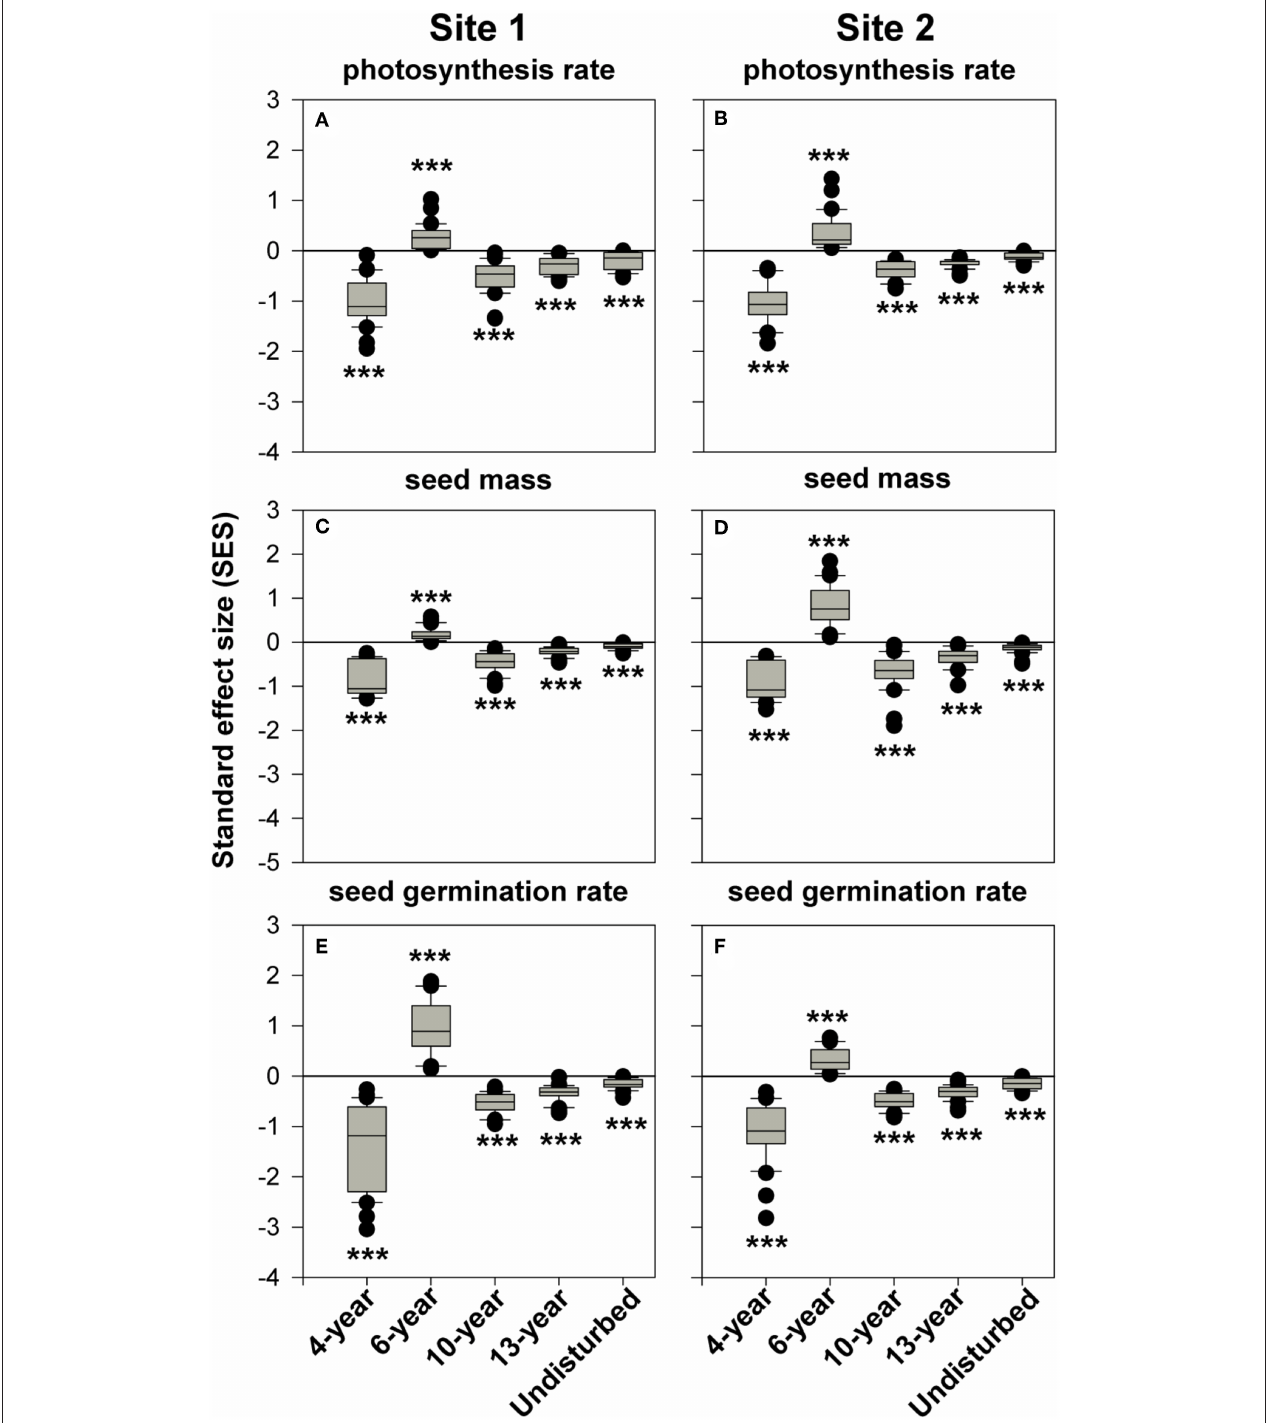
FIGURE 4 | The distributions of standard effect size (SES) in successional meadows. *** P < 0.001 for the Wilcoxon signed-rank test, for null hypothesis that SES is equal to zero. SES values significantly greater than, smaller than, or not different from zero, respectively, indicate significant trait divergence, trait convergence, or random distribution. The bottom and top of the box represent the 1st quartile and 3rd quartile of the data, respectively. The vertical lines extending from the box represents the data inside a range of 1.5 times the interquartile range from the box. Outliers are denoted by filled points. (A,C,E) Represent SES for photosynthesis rate, seed mass, and seed germination rate in chronosequence 1, respectively. Likewise, (B,D,F) indicate SES for photosynthesis rate, seed mass, and seed germination rate in chronosequence 2 individually.